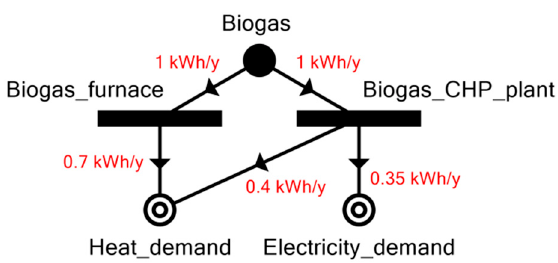
Figure 6. Biogas furnace and CHP plant modeling. Note that the material node “Biogas” is expressed as the heating values of the input materials instead of mass or